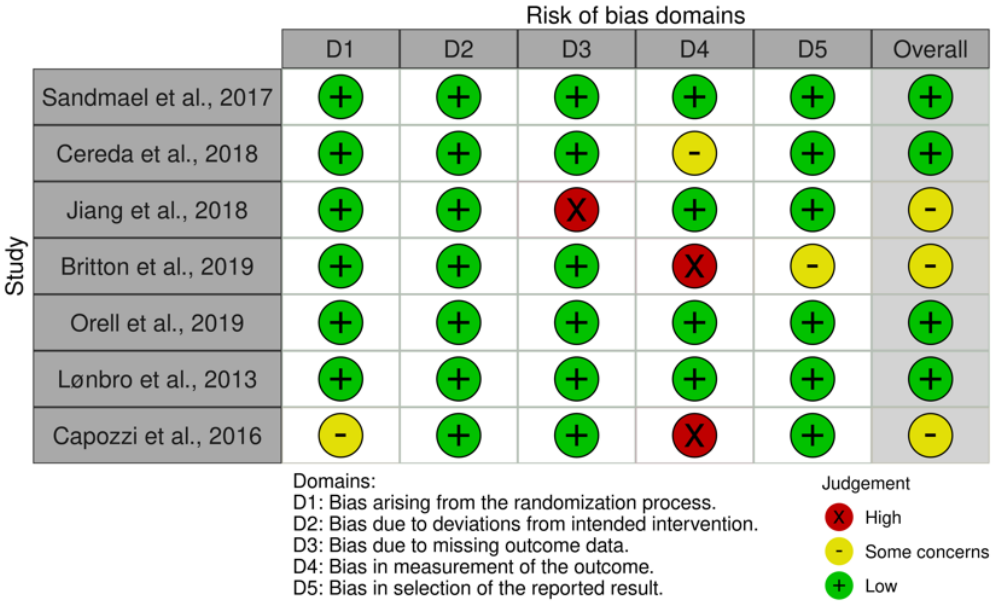
Figure 2. Risk of Bias Assessment [11,13,14,16,18 – 20].